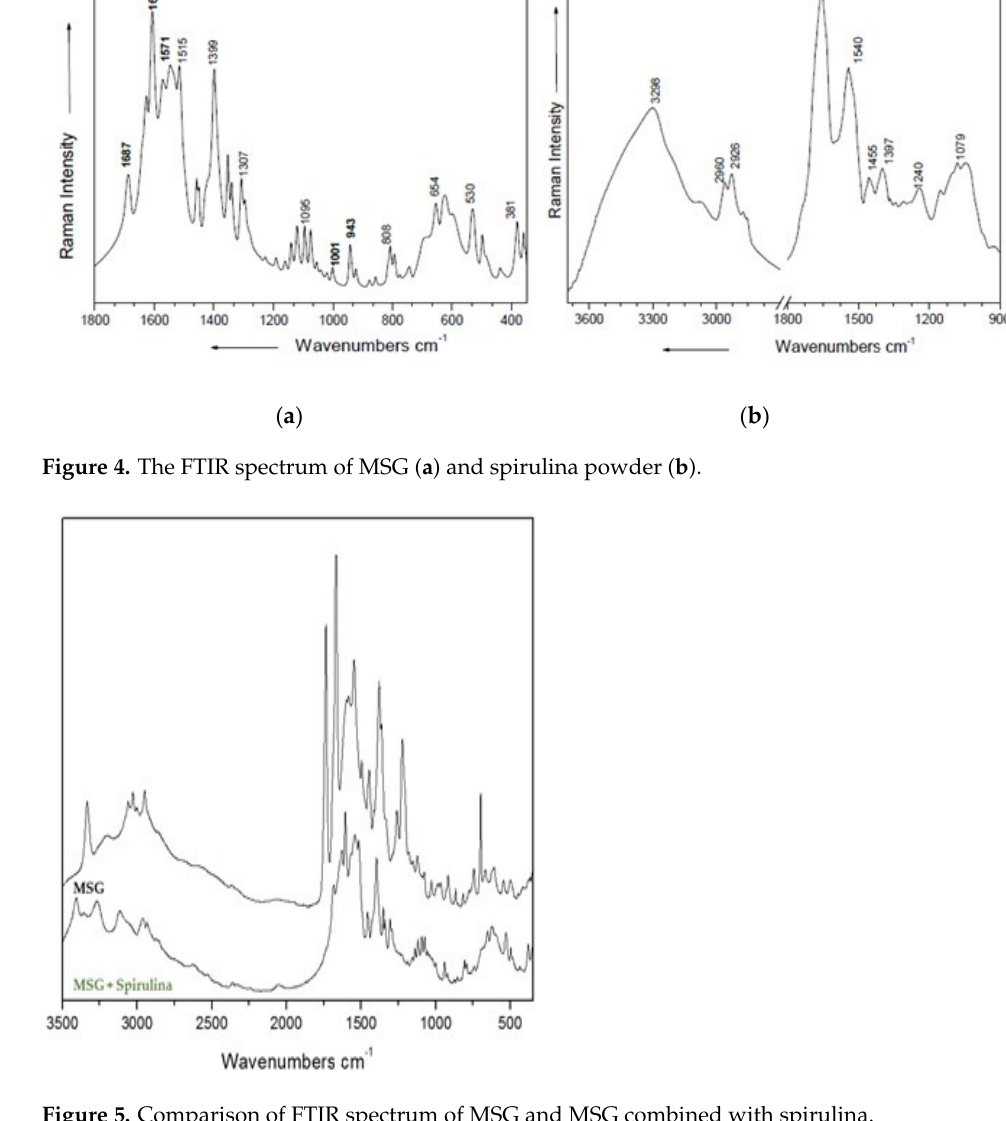
Figure 5. Comparison of FTIR spectrum of MSG and MSG combined with spirulina.